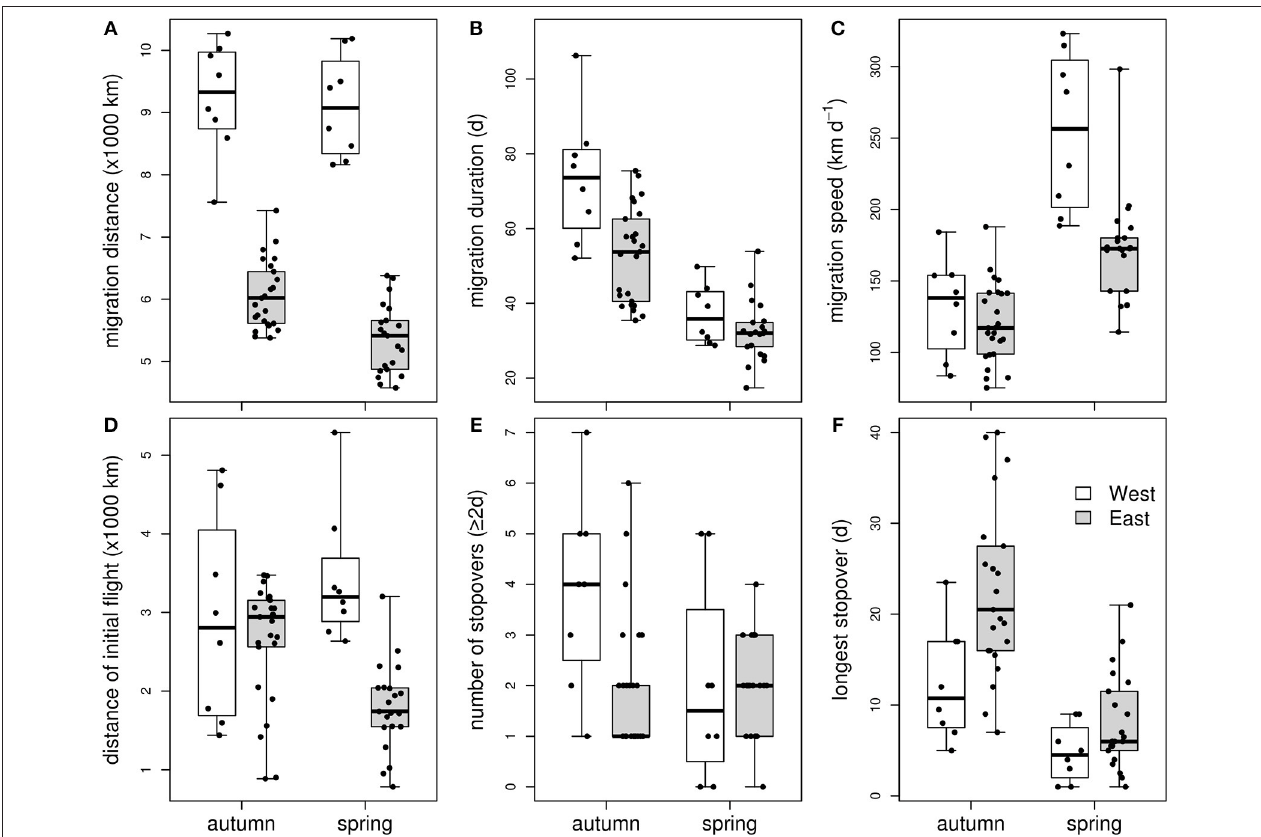
FIGURE 2 | Characteristics of autumn and spring migration of Red-necked Phalaropes migrating from breeding sites in Greenland, Iceland, and Scotland to the Pacific (“West”, white boxplots) or migrating from Fennoscandian-Russian breeding sites to the Arabian Sea (“East”, gray boxplots): migration distance (A) , duration of the migration periods (B) , migration speed (C) , distance of the first migration leg (D) , number of stopovers of at least 2 days (E) , and the duration of the longest stopover (F)